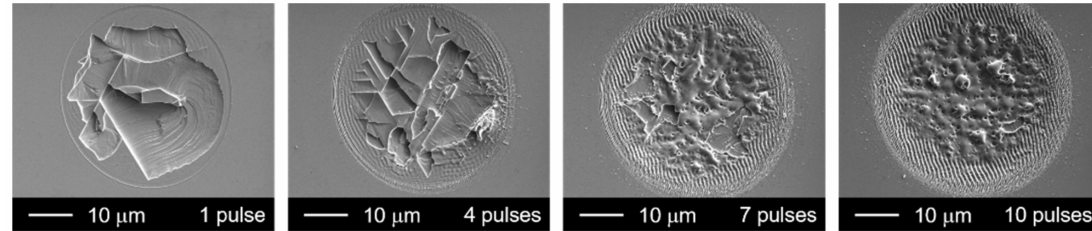
Figure 5. ZnO surface irradiated by laser pulses with the same pulse energy of 30 µ J but different pulse numbers (repetition rate: 10 Hz).